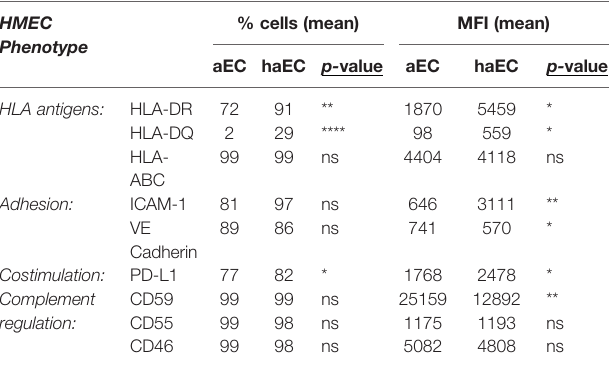
TABLE 2 | Phenotype of primary renal glomerular endothelial cells activated under pro-in fl ammatory cytokines. Renal glomerular endothelial cells phenotype